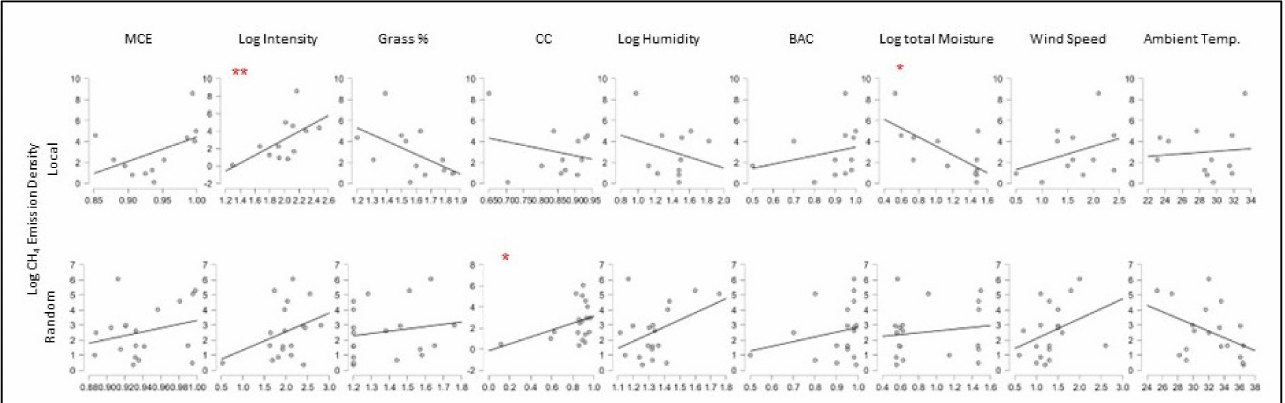
Figure 13. Methane ED Correlation Plots for Key Variables for Local and Random Fires (*** p < 0.001, ** p < 0.01, * p <